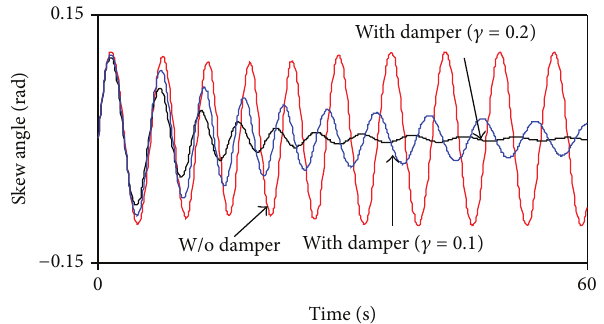
Figure 12: Effect of location parameter on the spreader skew angle.